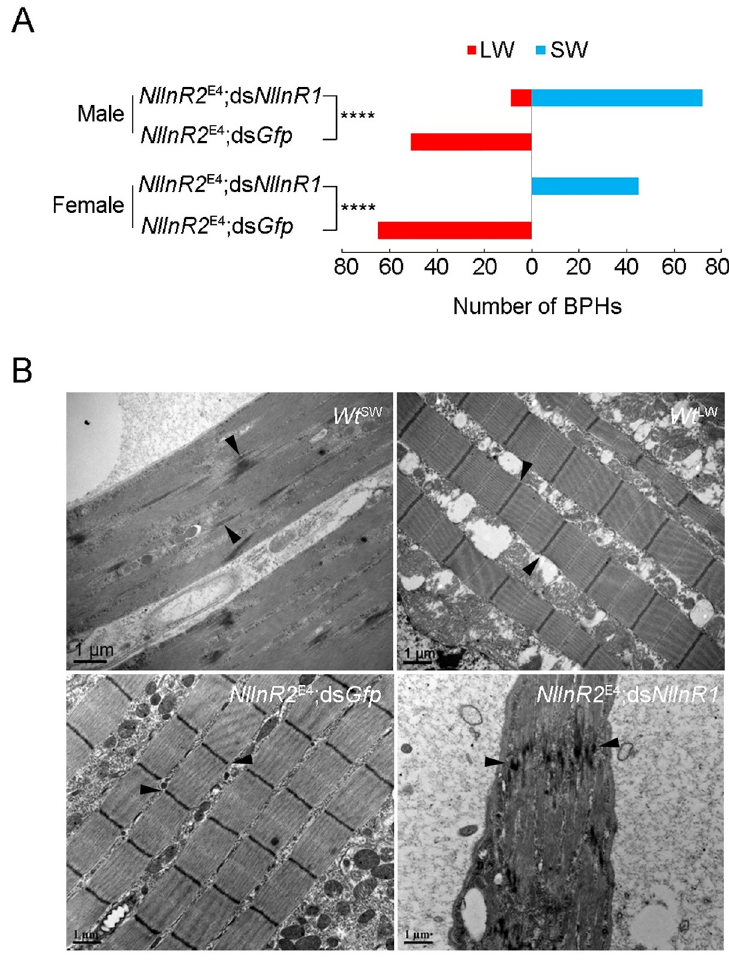
Fig 4. Knockdown of NlInR1 compromises NlInR2 -null mutants in terms of LW and indirect flight muscles development. Fifth-instar NlInR2 E4 nymphs at 12 hAE were microinjected with dsRNAs targeting NlInR1 ( NlInR2 E4 ; ds NlInR1 ) or Gfp ( NlInR2 E4 ;ds Gfp ). Long-winged (LW) and short-winged (SW) adults were counted after adult eclosion (A) . Groups were compared Pearson’s χ 2 test ( ���� , P < 0.0001). Thoraxes were dissected from 24h-female adults for indirect flight muslces examination by transmission electron microscopy (B) . Wt SW , wild-type short-winged BPHs. Wt LW , wild-type long-winged BPHs. The Z discs of indirect flight muscles indicated by arrowheads.